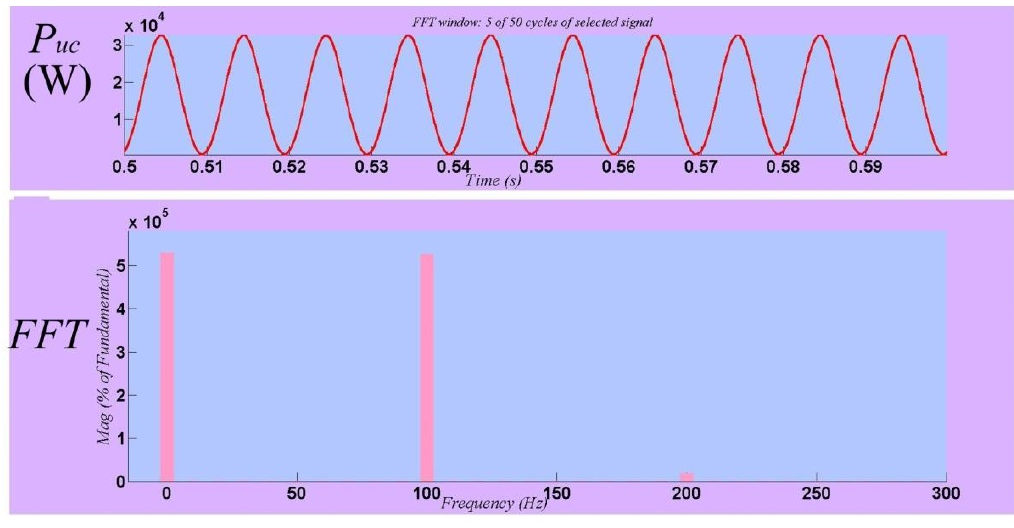
Figure 7. Spectrum of instantaneous power of UC.